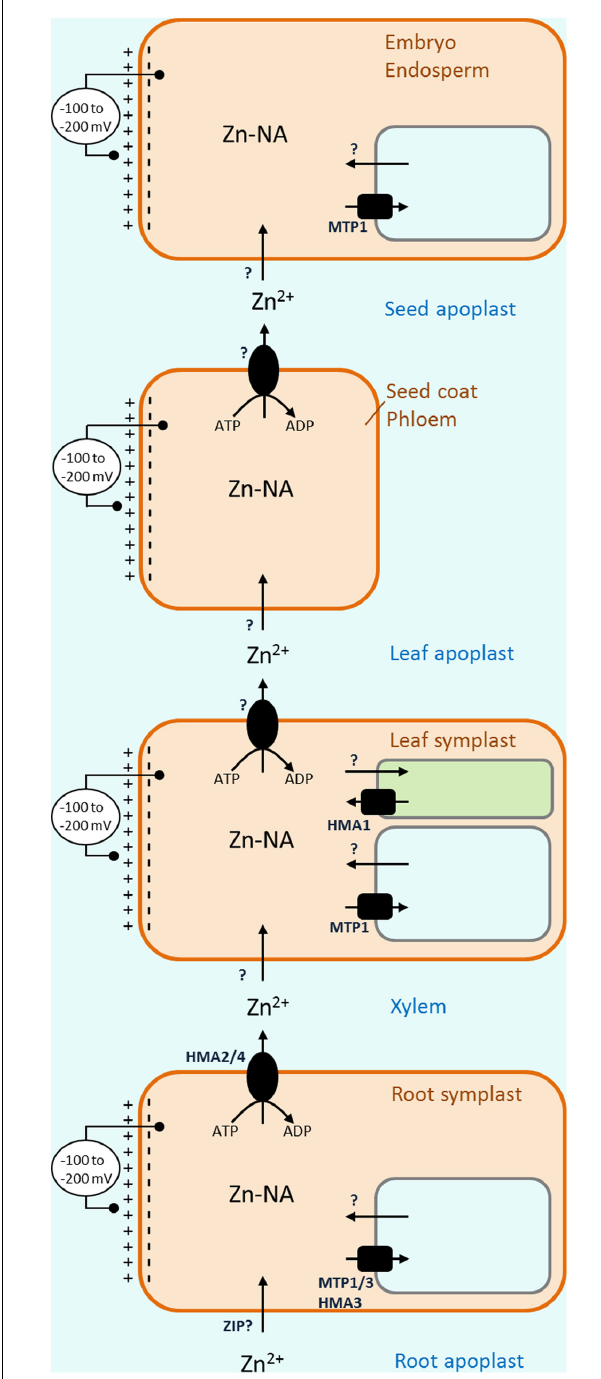
FIGURE 1 | Overview of transport barriers leading to loading of zinc into seeds. Following uptake of zinc into the root symplast, at least three apoplastic barriers have to be crossed on the way to the seed. Substantial membrane potentials cross the membranes of the plasma membrane, vacuole and chloroplast, transport of zinc into the cytoplasm, out of the vacuole or into the chloroplast is energetically favorable, requiring passive transporters only (arrows). On the other hand, transport out of the cytosol, into the vacuole or out of the chloroplast requires active transporters or secondary active transporters (round and square symbols,